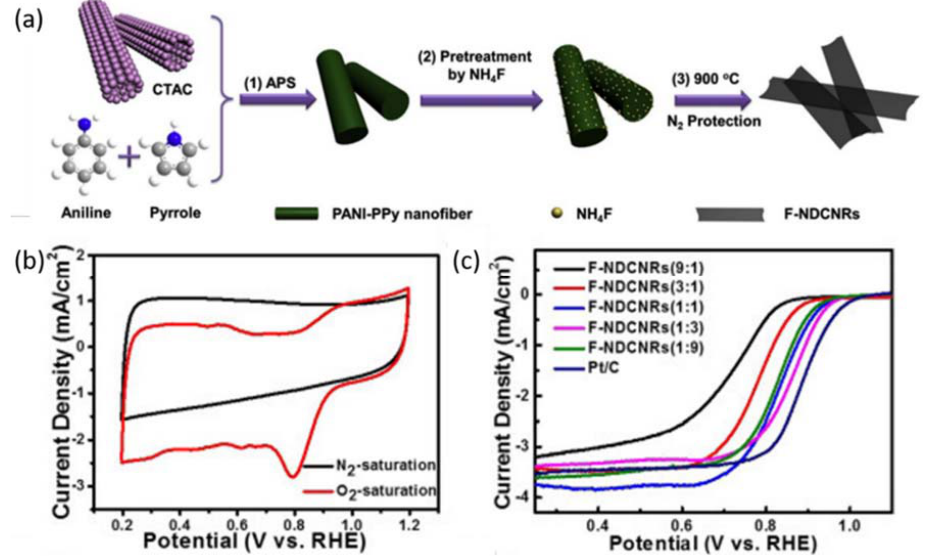
Figure 7. ( a ) Schematic illustration of preparing F-NDCNRs (x); ( b ) CV curve of F-NDCNRs (1:3) in N 2 and O 2 -saturated 0.1 M KOH; ( c ) LSVs of F-NDCNRs (x) with a rotating rate of 900 rpm [106].